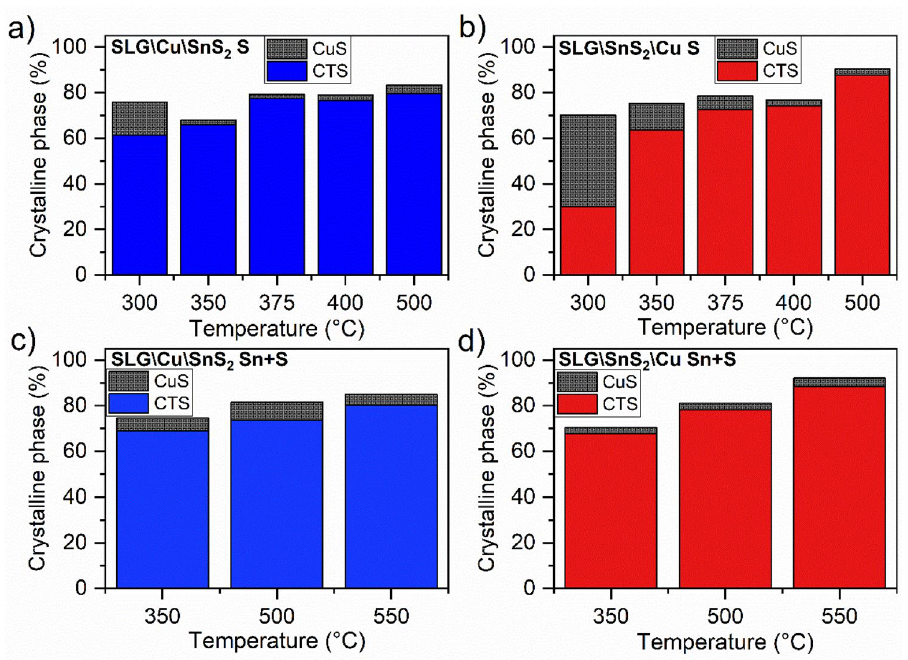
Figure 3. Crystalline CTS (tetragonal, cubic or monoclinic) and CuS phases percentages of the stacks annealed at different temperatures. ( a ) SLG\Cu\SnS 2 S, ( b ) SLG\SnS 2 \Cu S, ( c ) SLG\Cu\SnS 2 Sn + S, ( d ) SLG\SnS 2 \Cu Sn + S.